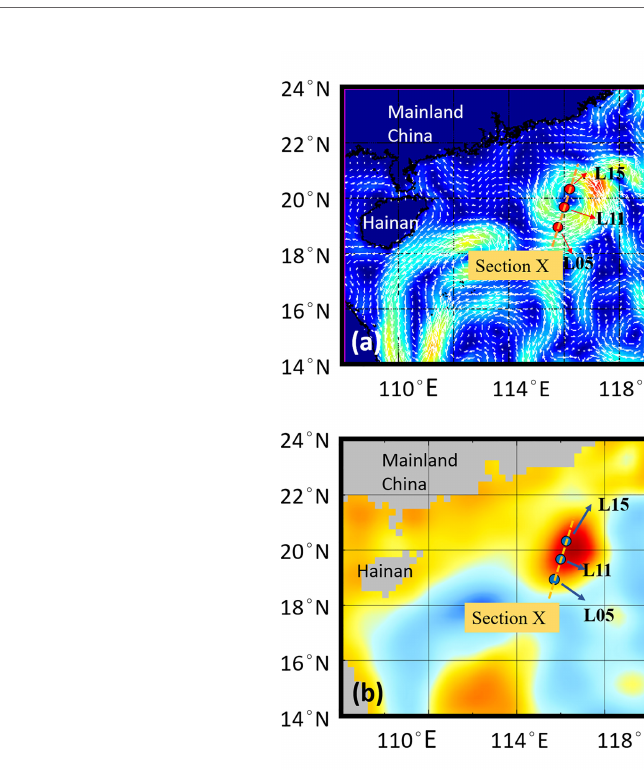
FIGURE 1 | Map of sampling stations in Northern slope of South China Sea in March 2017. Depth pro fi les of SPE-DOM were obtained for stations L05 and L11. Chromophoric and fl uorescent DOM were recorded in section X, including L05, L11 and L15. The color and vectors in (A) represented the velocity and direction of geostrophic fl ow. The color in (B) represents a sea level anomaly caused by ACE. This map was generated through combining SLA and surface geostrophic current velocity distributed by AVISO;